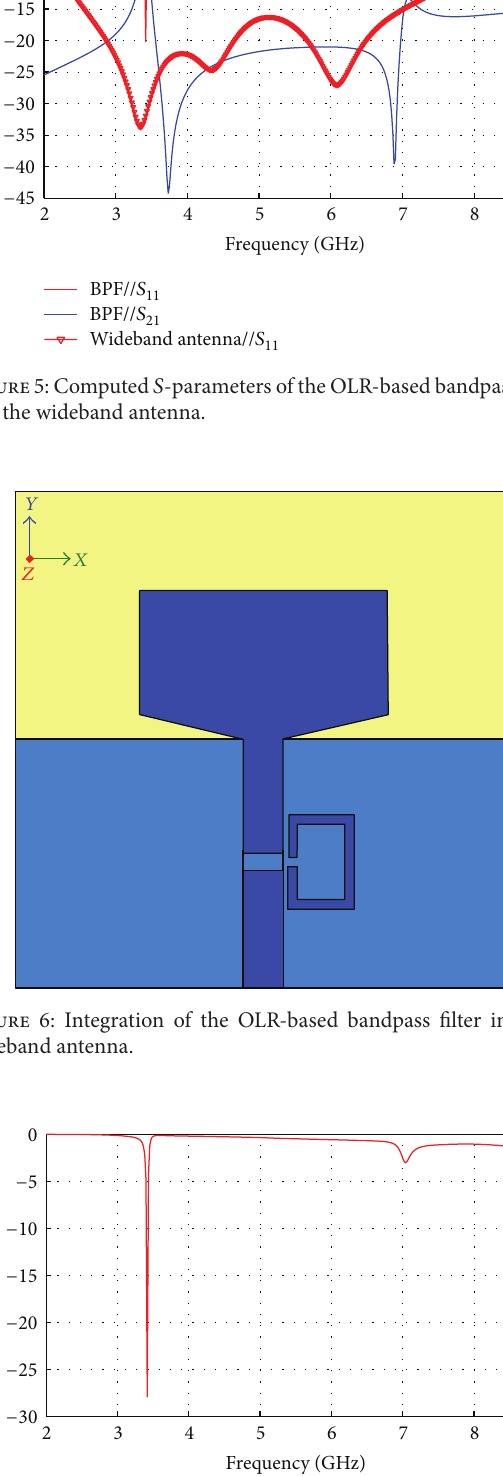
Figure 7: Simulated reflection coefficient of the assembled struc-